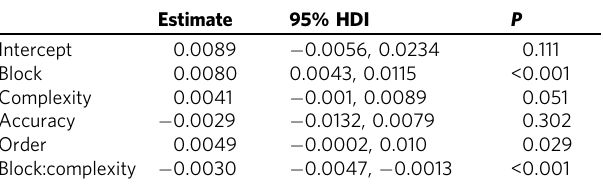
Table 3 Results of the Bayesian-estimated linear mixed effects regression model of PC category discrimination across learning blocks and problem complexity.